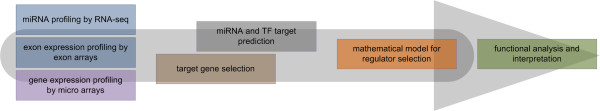
Transcriptome analysis pipeline. Pipeline for the integrative analysis of the MDS transcriptome, further described in the text and Additional file 5 Figure S4.